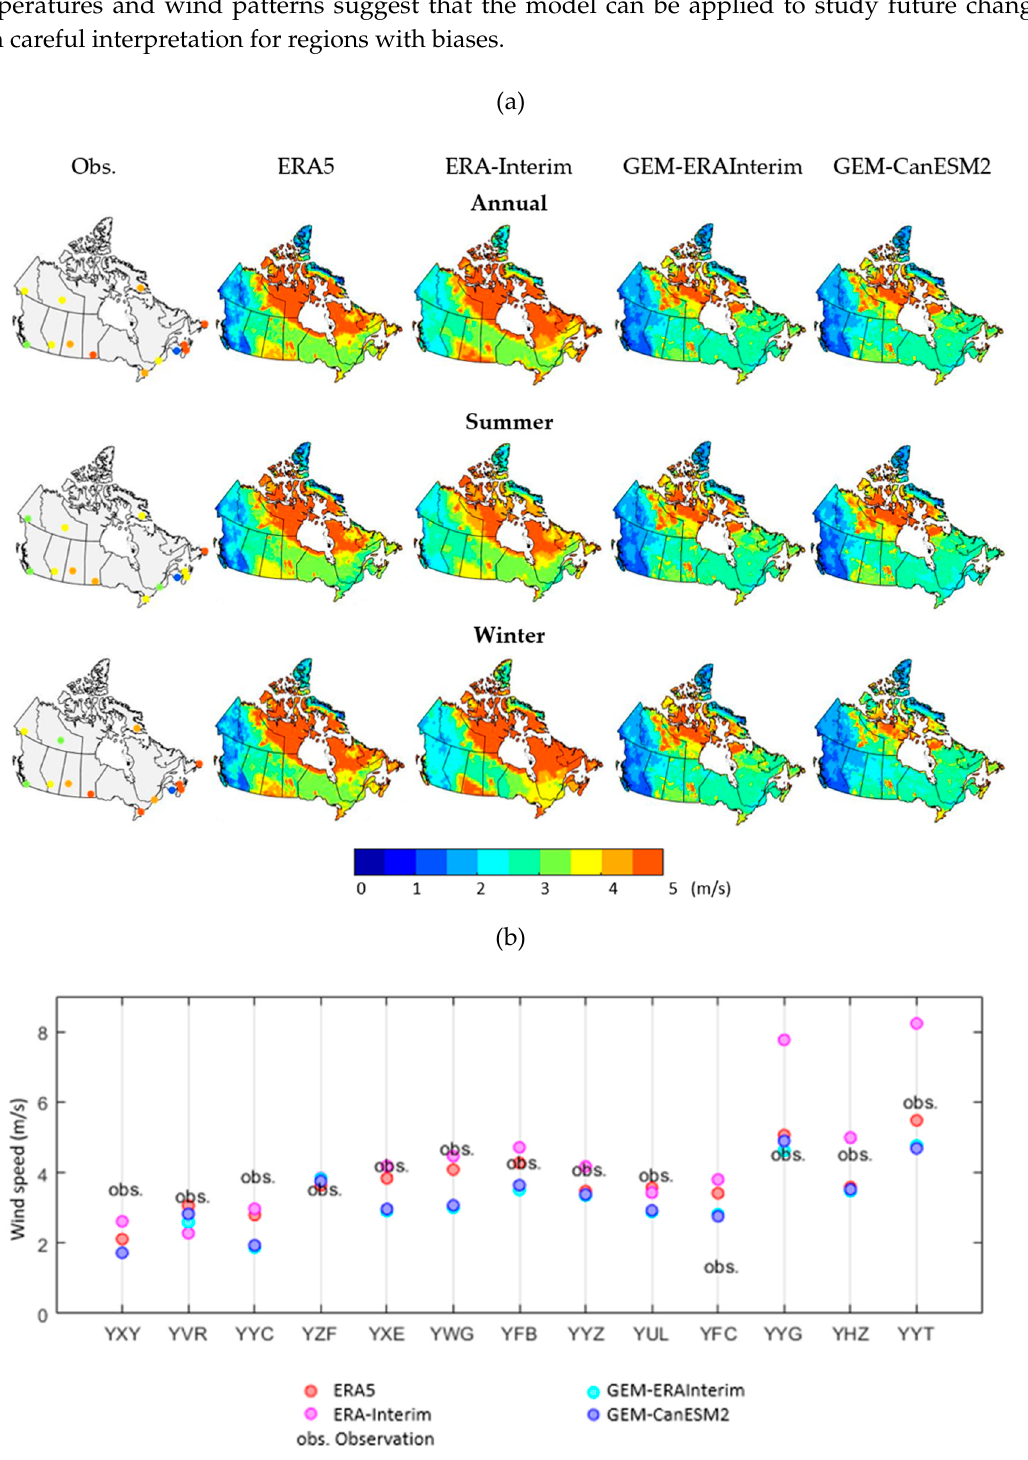
Figure 3. ( a ) Spatial plots of mean annual, summer and winter 10 m wind speeds and ( b ) point (airfield) values of 10 m mean annual wind speed for observations, ERA5 reanalysis, ERA-Interim reanalysis, GEM-ERAInterim and GEM-CanESM2, for the 1981–2010 period.